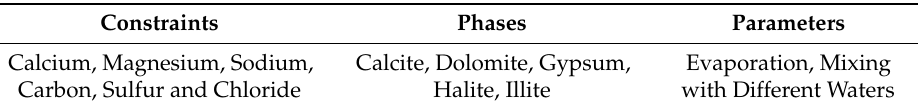
Table 2. Constraints, phases, and parameters used in NETPATH models.